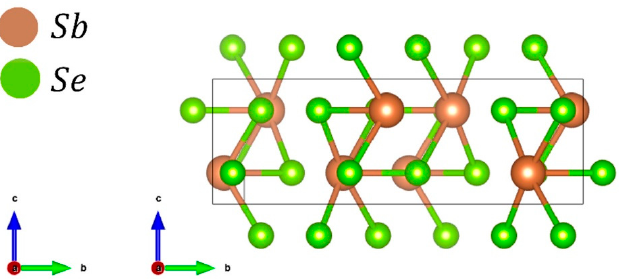
Figure 2. Spatial representation of atoms in Sb 2 Se 3 crystal structure referred to orthorhombic Pbnm space group.